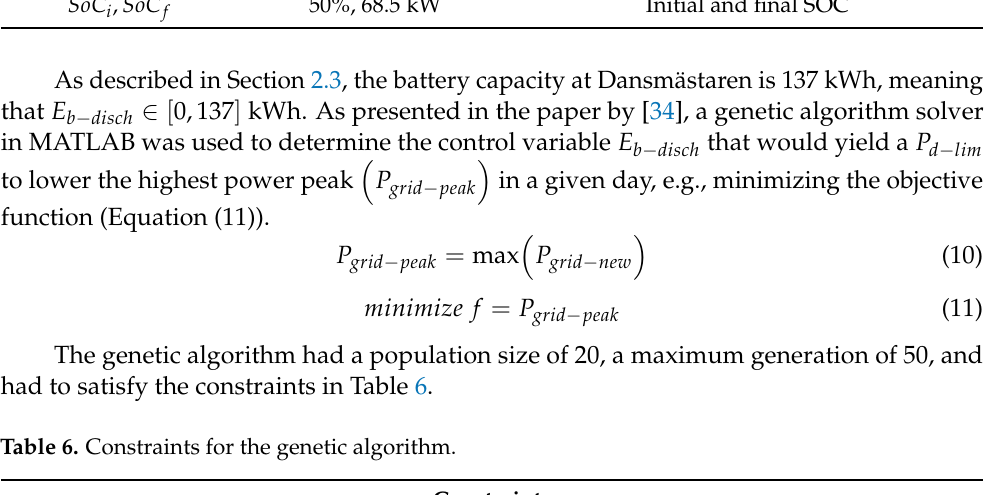
Table 5. Variables for rule-based control.